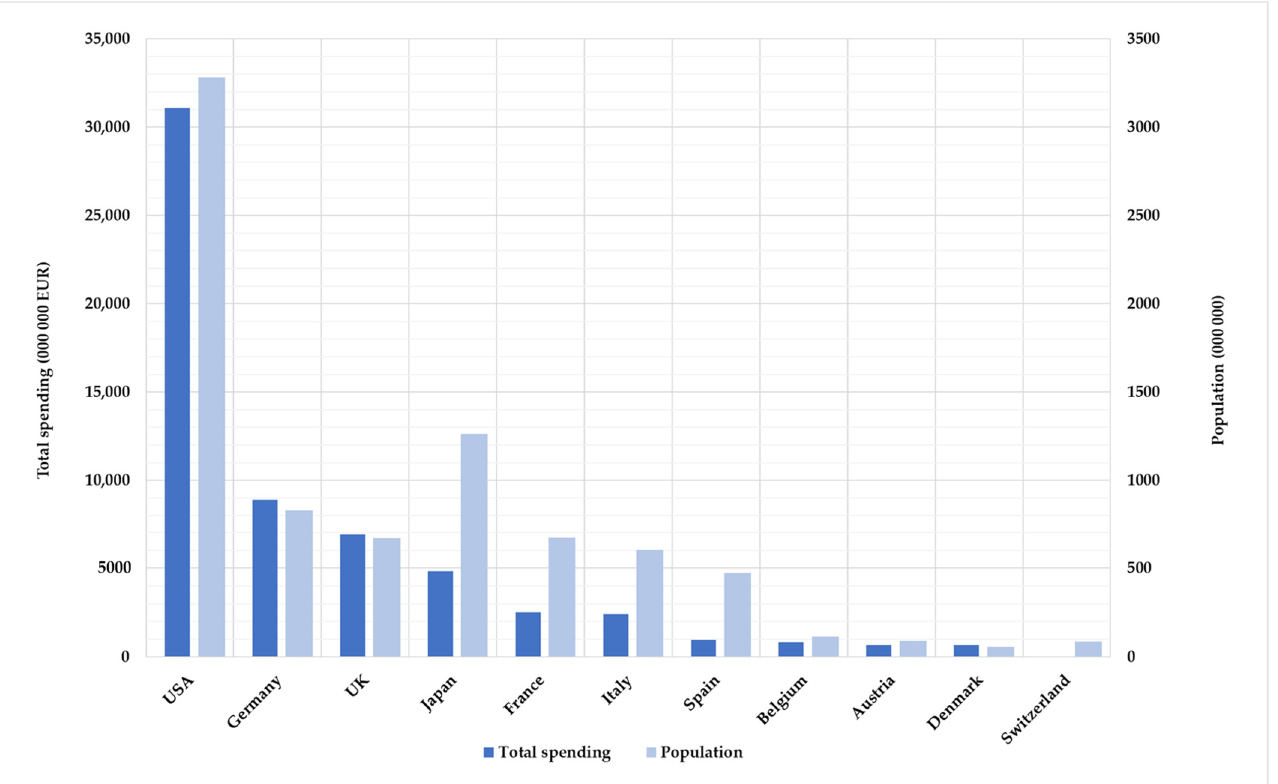
Figure 4. Consumption of flowers and plants (and related goods): total spending (EUR 000 000) over population (000 000) in major world country markets (excl. China). Source: our elaboration on [50]. 1 The data of total spending refer to the latest available year in the timeframe 2015–2019. The reported data do not include the share of spending concerning the market for services, e.g., floral and garden design, landscaping, green urban planning, green urban maintenance, etc.